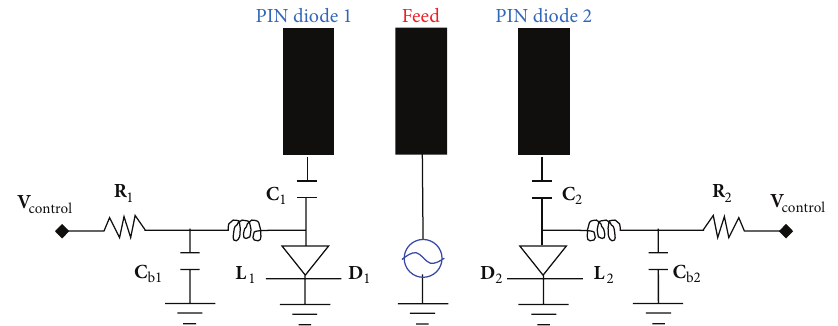
Figure 12: The bias circuit of the PIN diodes feed network.